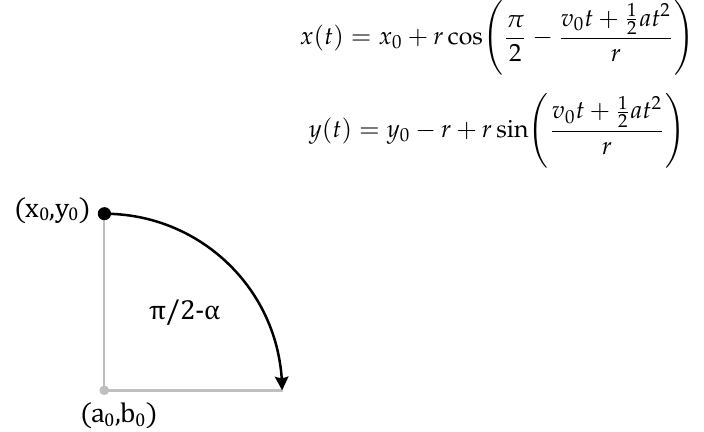
Figure 15. Changing the starting point of an arc (with an accuracy of 90°): ( a ) Clockwise motion and ( b ) counter clockwise motion.